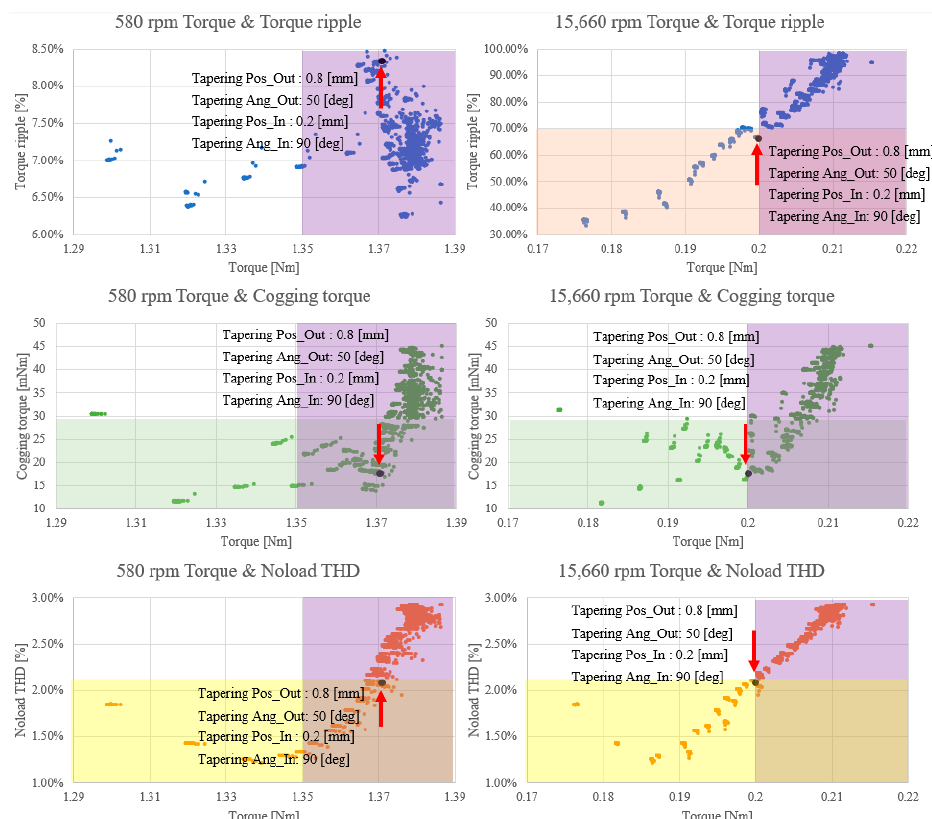
Figure 9. Results of the second 2D finite element analysis at washing and dehydrating load.